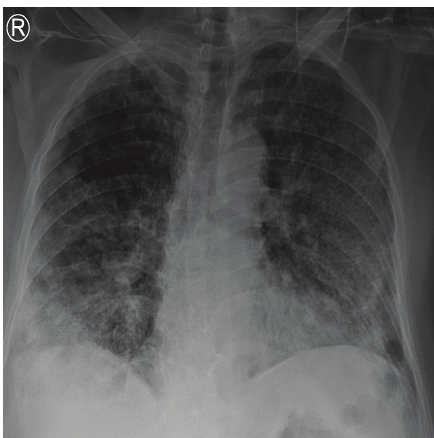
Figure 3. CXR of COVID-19 subject showing severe lung tissue involvement.